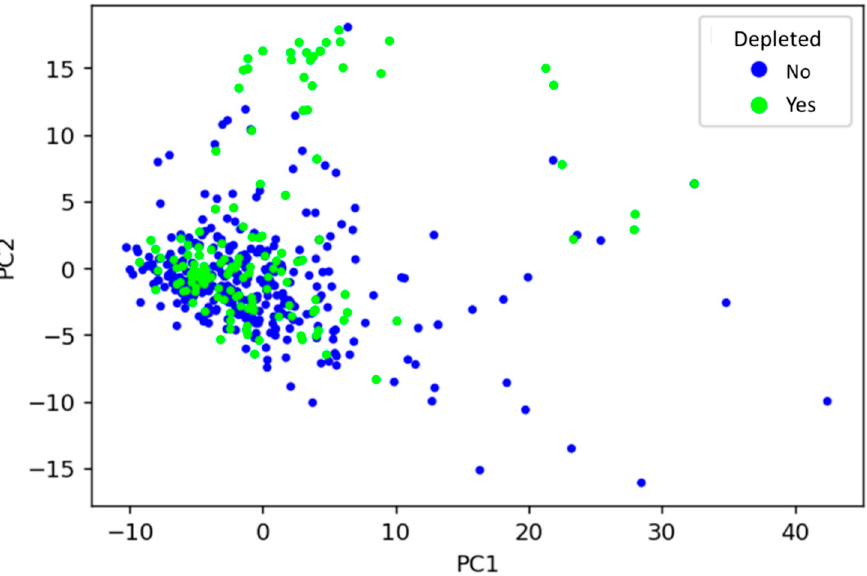
Figure 2. Visualisation of the relationship between drugs’ physicochemical features and whether they are depleted by gut microbiota, using principal component analysis. PC1: principal component 1, PC2: principal component 2. PC2: principal component